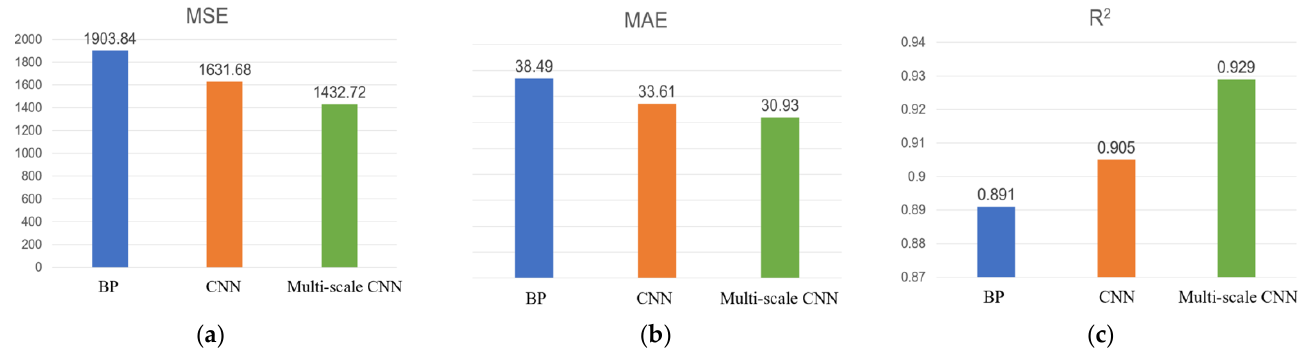
Figure 8. ( a ) MSE of each model in the test set; ( b ) MAE of each model in the test set; ( c ) R 2 of each model in the test set.